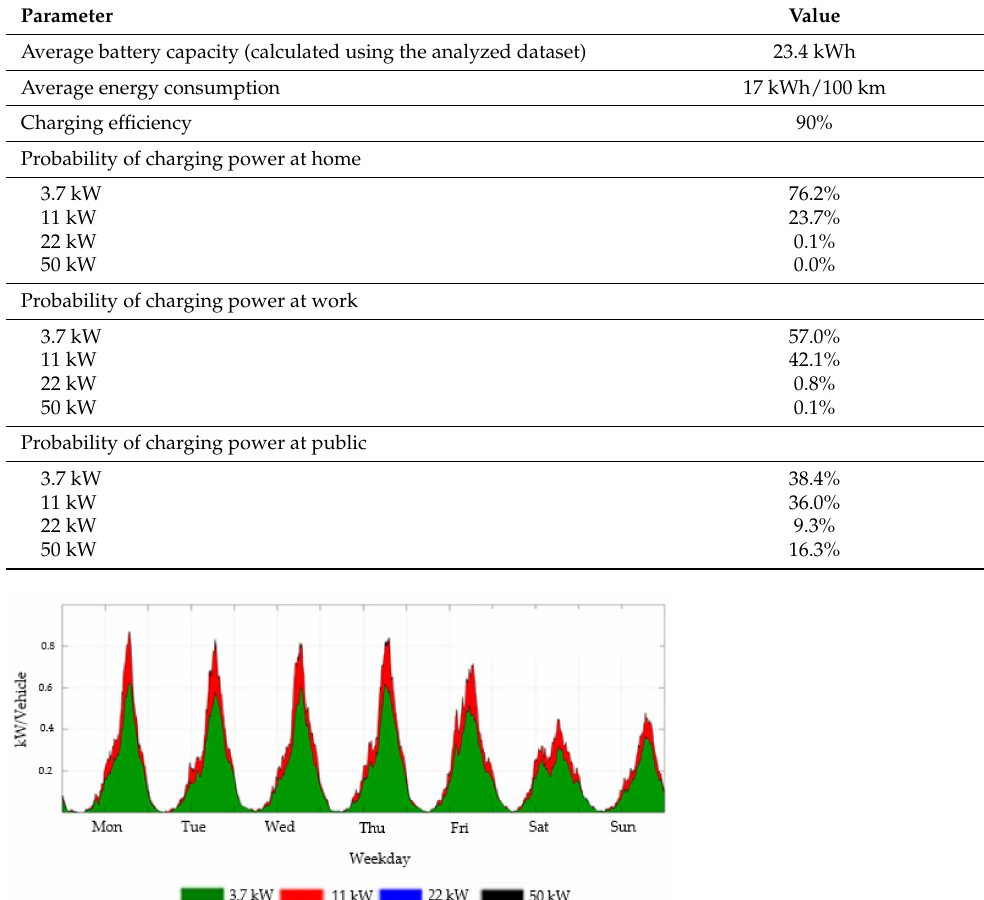
Table A2. Further input data for the MobiFlex model.